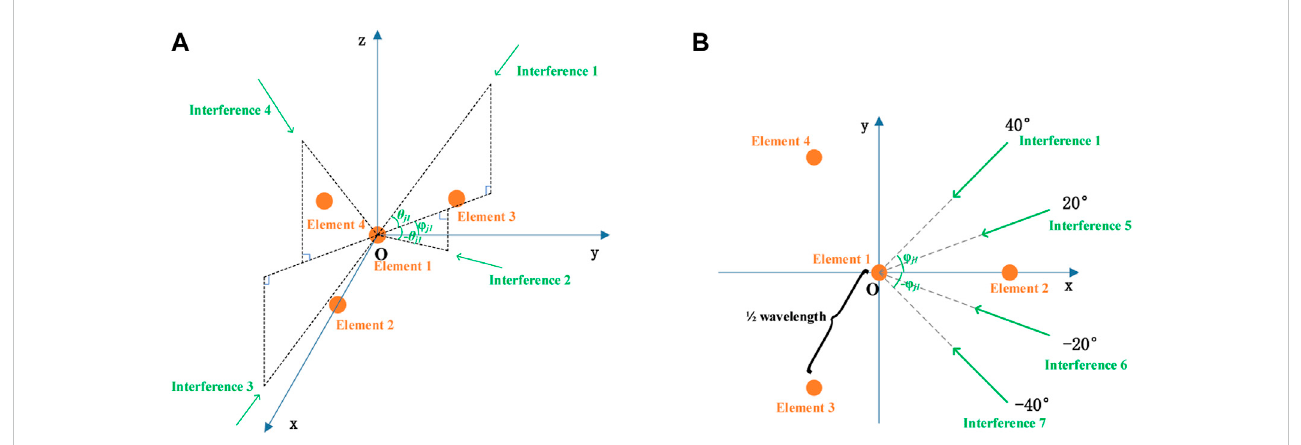
FIGURE 2 The position of the central UCA with four elements in the Oxyz coordinate system. (A) Three-dimensional fi gure; (B) xOy Planar 2D fi